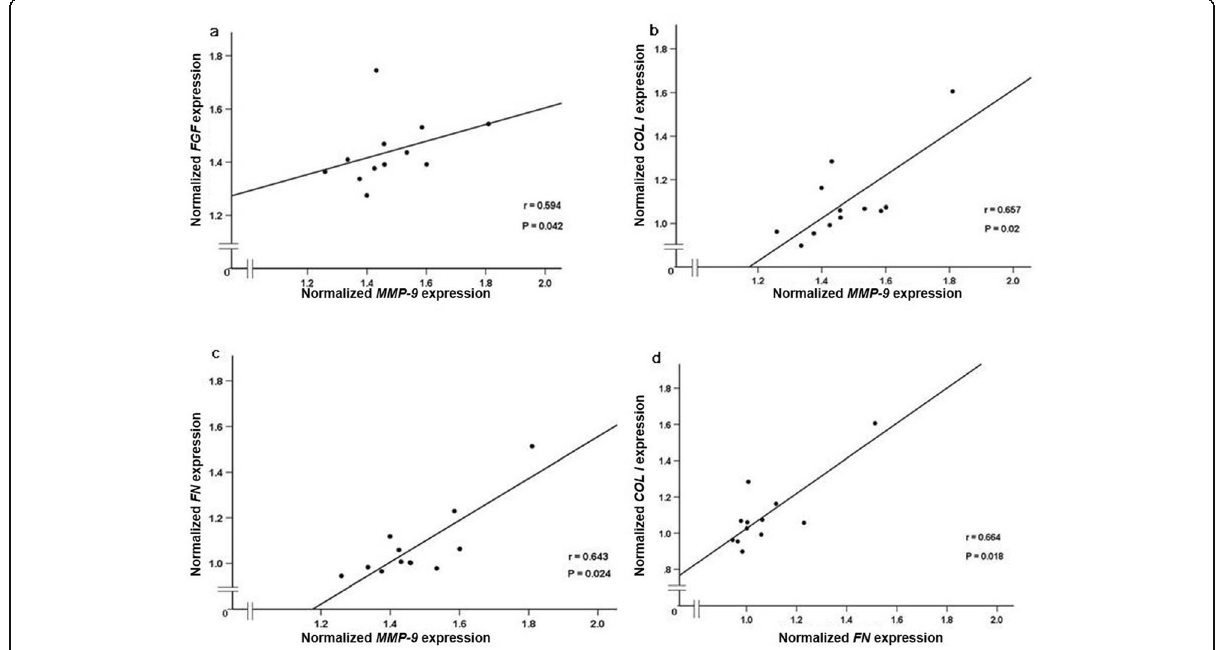
Fig. 5 Associations among gene expression of a MMP-9 and FGF , b MMP-9 and COL I , c MMP-9 and FN and, d FN and COL measured by Spearman ’ s rank correlation coefficient. n = 12